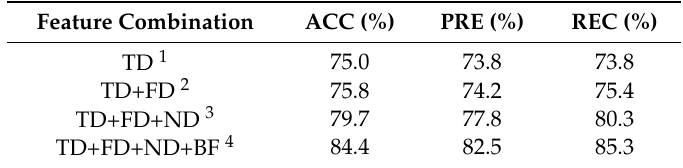
Table 6. The most powerful CARs in hypertensive group and normal